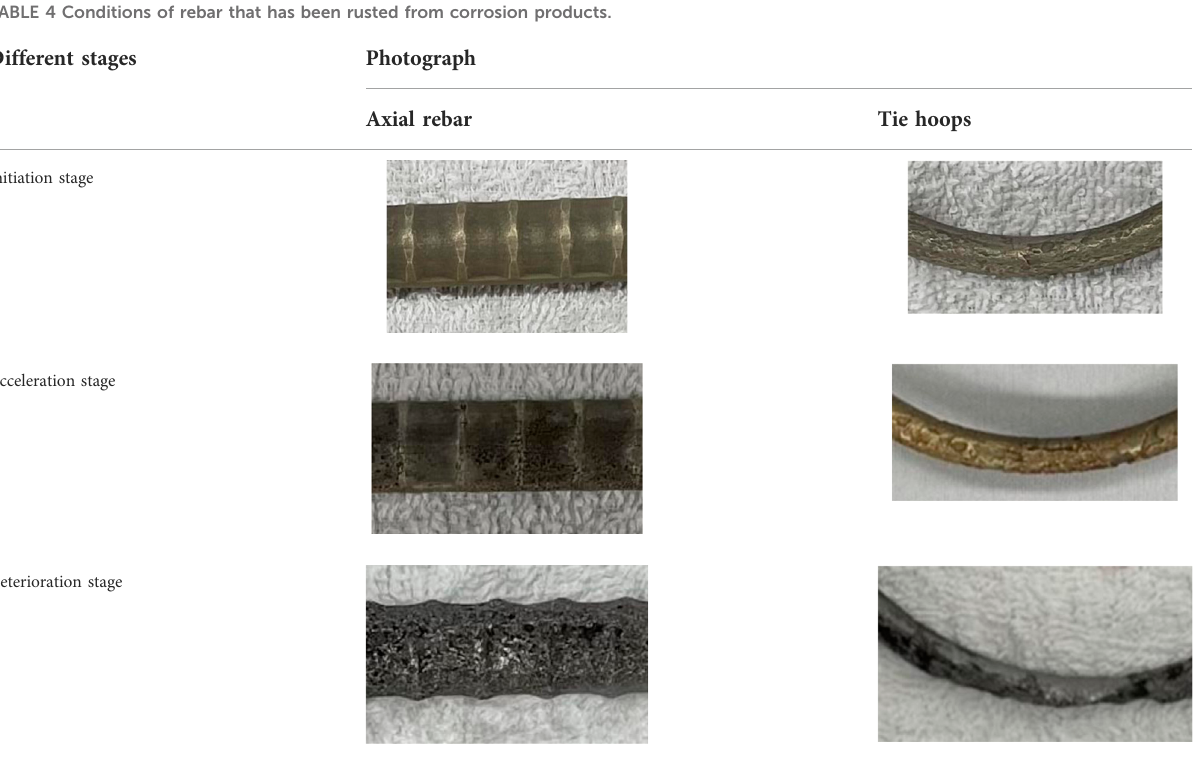
TABLE 4 Conditions of rebar that has been rusted from corrosion